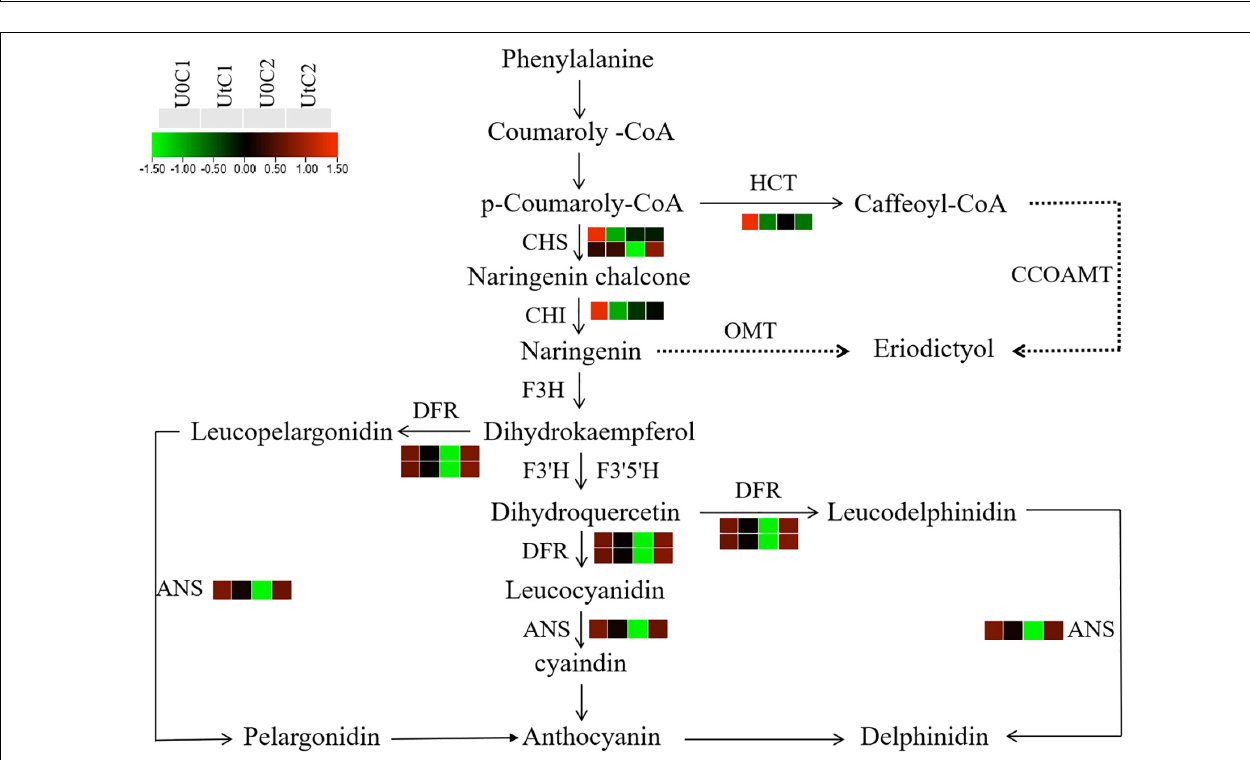
FIGURE 15 | Heatmap of differentially expressed genes (DEGs) related to flavonoid biosynthesis in Mingui 1 and Mingui 2. Heat maps were drawn using log2-transformed FPKM values.